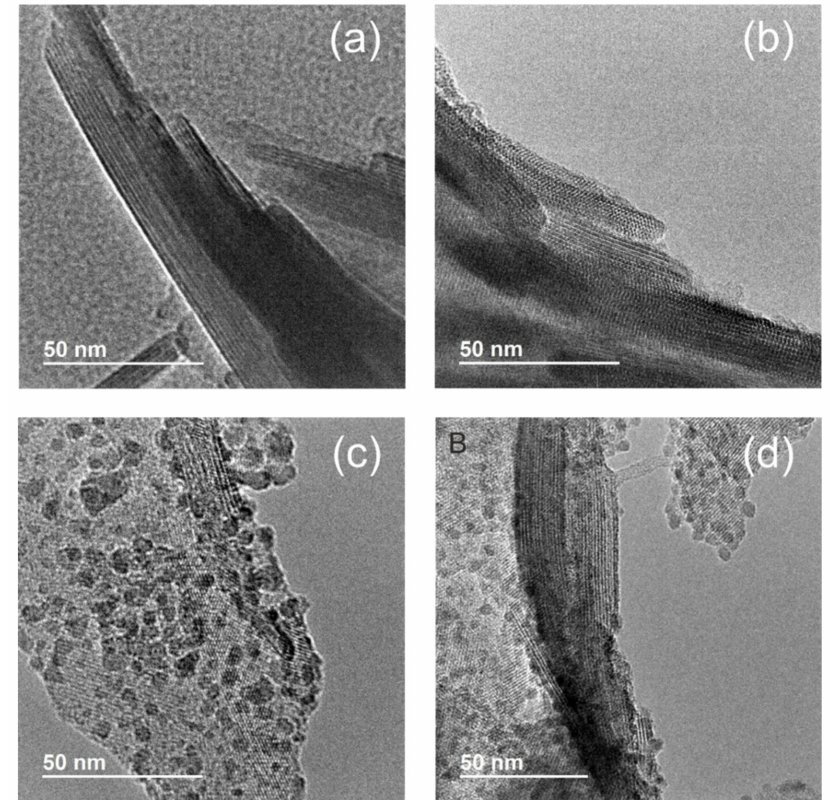
Figure 3. HRTEM micrographs of the MCM-22 and ITQ-2 samples modified with FeSO 4 · 7H 2 O and [Fe 3 (OCOCH 3 ) 7 · OH · 2H 2 O]NO 3 by ion-exchange: ( a ) Fe(S,IE)MCM-22, ( b ) Fe(S,IE)ITQ-2, ( c ) Fe(O,IE)MCM-22, and ( d )